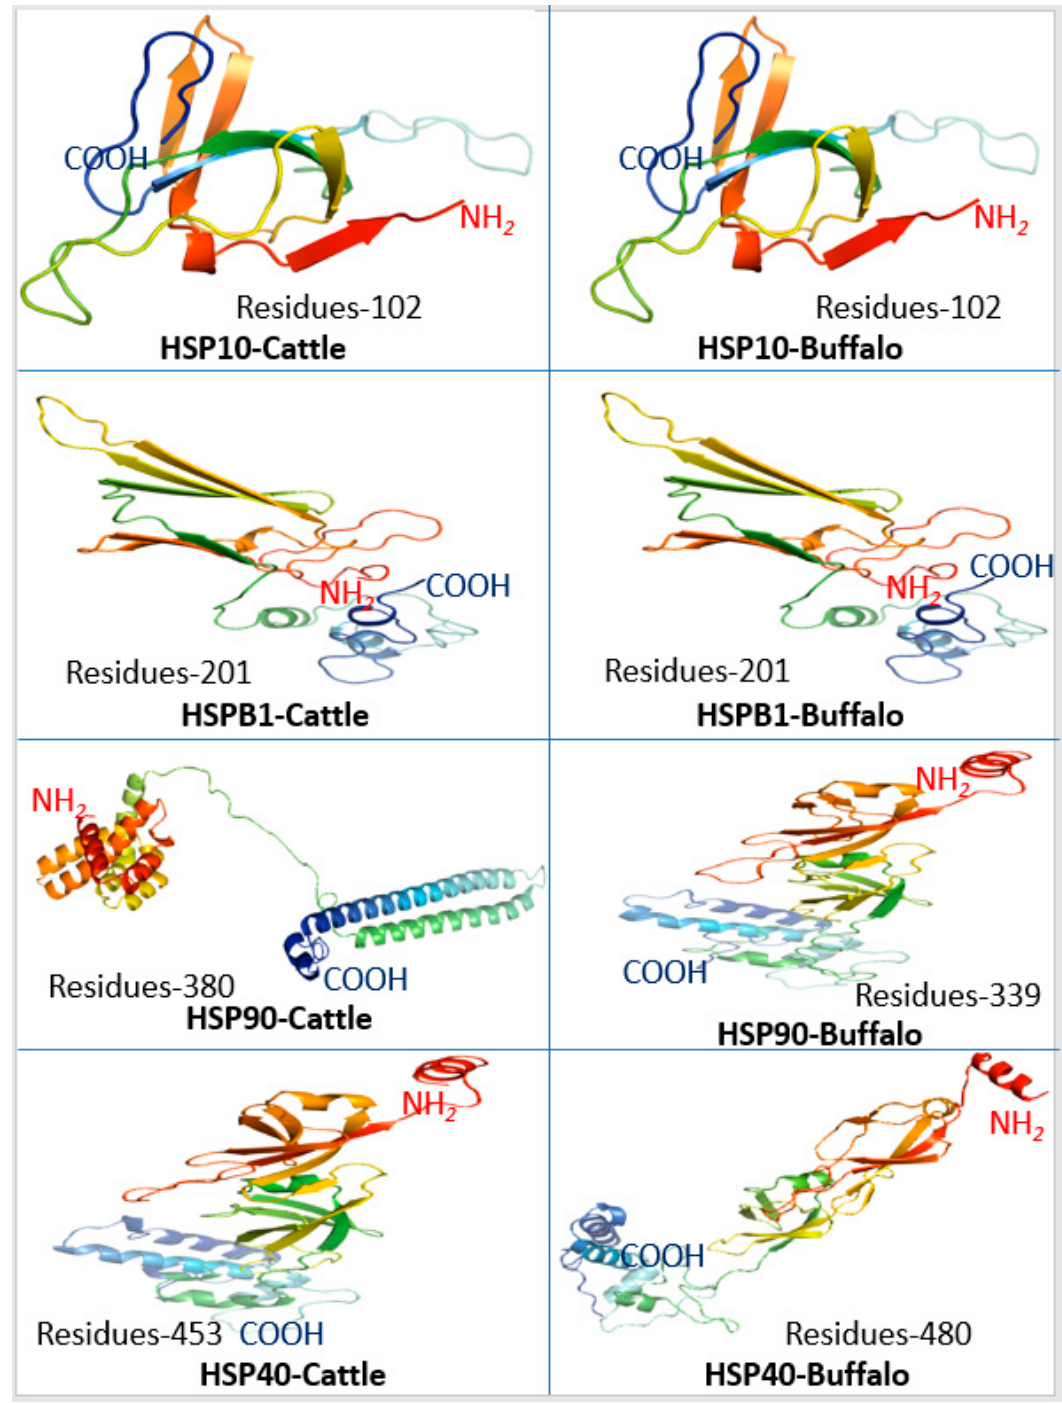
Figure 5. Three-Dimensional protein configuration of Heat-Shock Proteins in Bos taurus and buffalo